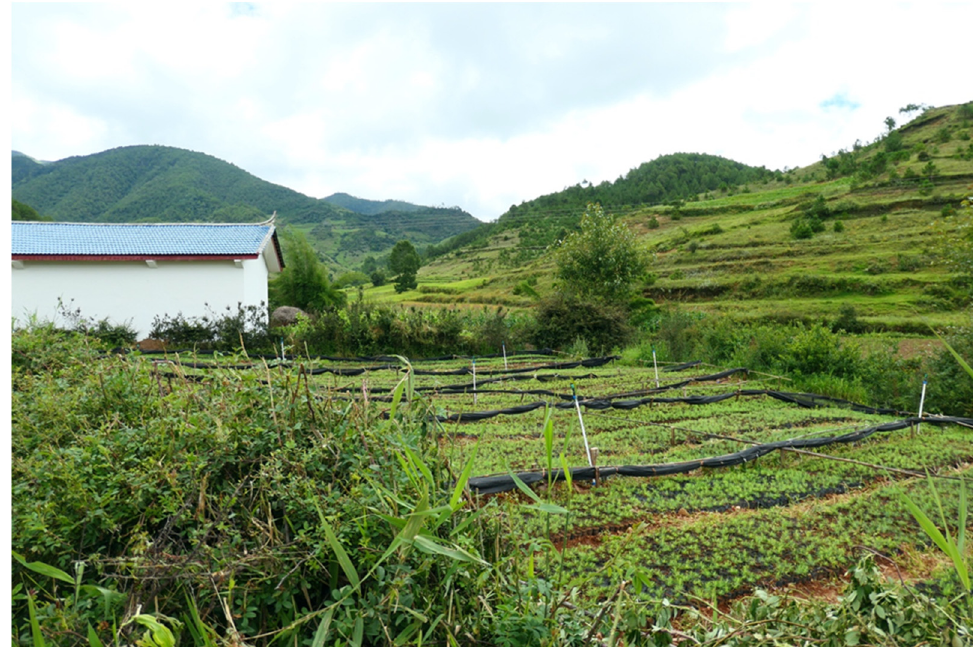
Figure 8. Yunnan pine trees being cash cropped with irrigation in Niplat, 2019. Photograph by the author.